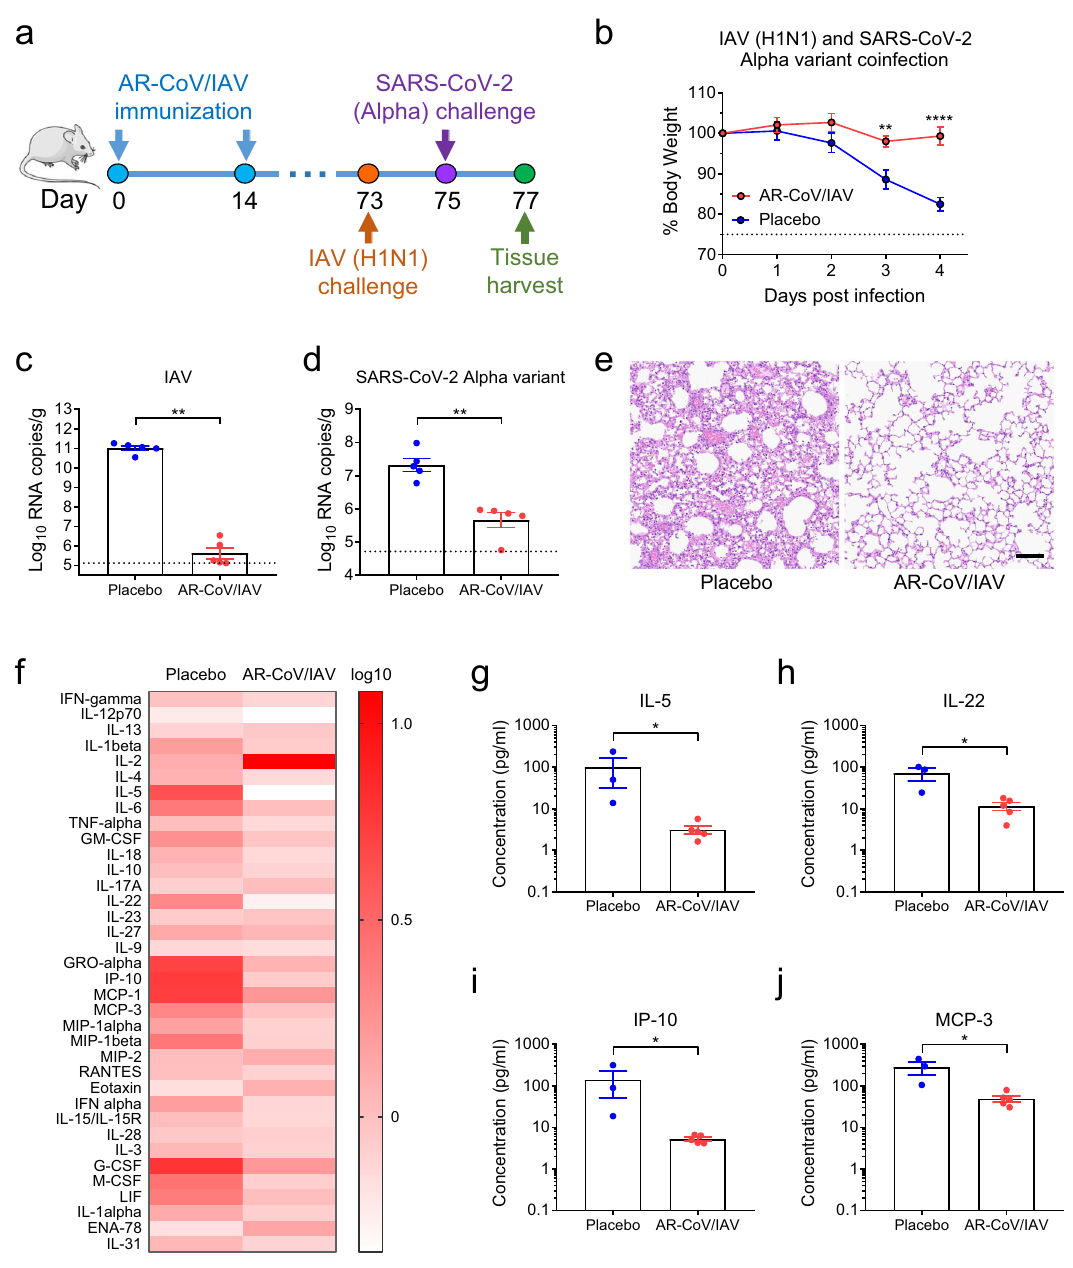
Fig. 5 AR-CoV/IAV confers protection against coinfection with IAV and the SARS-CoV-2 Alpha variant in mice. a Schematic diagram of experimental design. Groups of AR-CoV/IAV- or placebo-immunized mice were intranasally challenged with 2 × 10 5 PFU of IAV (A/California/ 07/2009) 73 days after the initial immunization, followed by infection with 4 × 10 3 PFU of the SARS-CoV-2 Alpha variant 2 days later. Mice were sacri fi ced 4 days after IAV infection for viral detection and histopathological analysis. b Weight changes in infected mice ( n = 5) were recorded for 4 days post-infection and are shown as the mean ± SEM. c , d Viral RNA copies of IAV ( c ) and SARS-CoV-2 ( d ) in the lung tissues of infected mice ( n = 5) were determined by qRT – PCR and are shown as the mean ± SEM. e Histopathologic analysis of lung sections from coinfected mice. Scale bar, 100 μ m. f Serum cytokine and chemokine analyses were determined by Luminex and are presented as fold changes compared to samples collected before infection (AR-CoV/IAV, n = 5; placebo, n = 3). g – j Concentrations of cytokines and chemokines in serum samples collected post-infection. Data are shown as the mean ± SEM. Statistical differences were analyzed by using two-way ANOVA with multiple comparison tests or two-tailed unpaired t tests. * P < 0.05, ** P < 0.01, **** P <